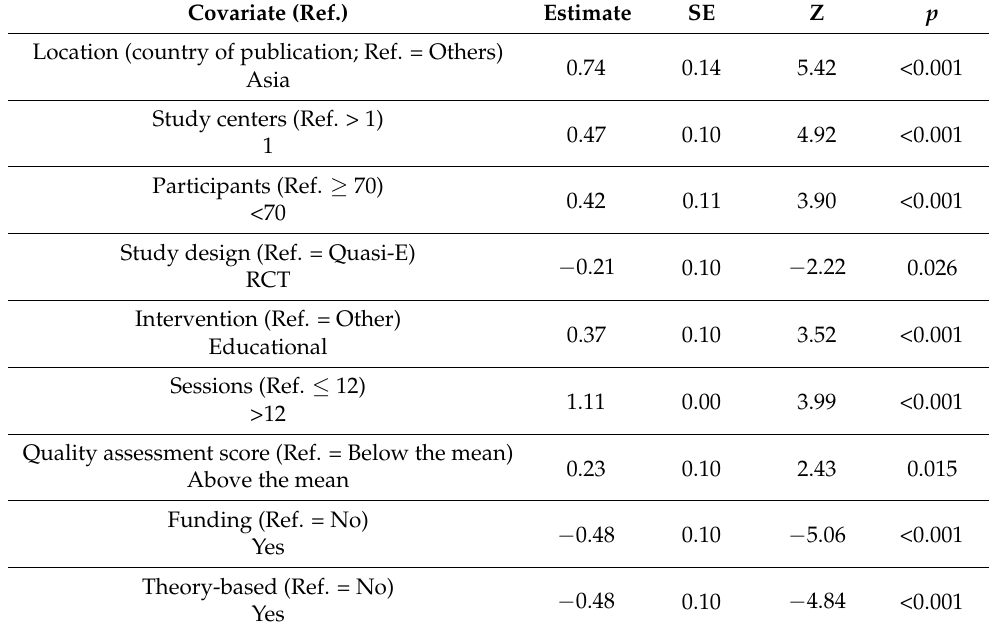
0.74 0.14 5.42 <0.001 0.47 0.10 4.92 <0.001 0.42 0.11 3.90 <0.001 − 0.21 0.10 − 2.22 0.026 0.37 0.10 3.52 <0.001 1.11 0.00 3.99 <0.001 0.23 0.10 2.43 0.015 − 0.48 0.10 − 5.06 <0.001 − 0.48 0.10 − 4.84 <0.001